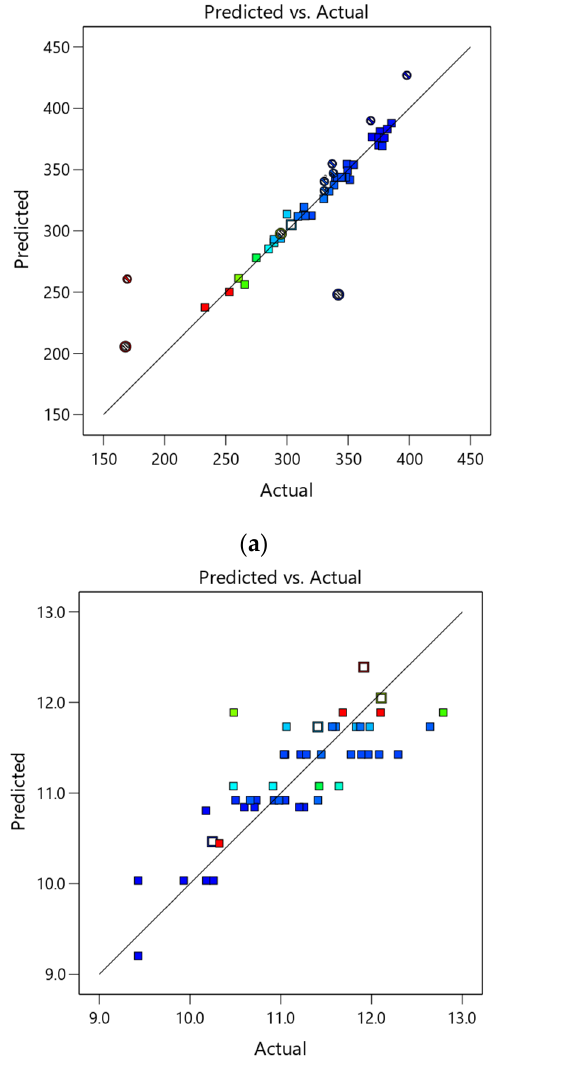
( d ) Figure 9. Effect of the Vs/Vm and Vw/Vp ratios on ( a ) D-flow and ( b ) T-funnel; effect of Vw/Vc and